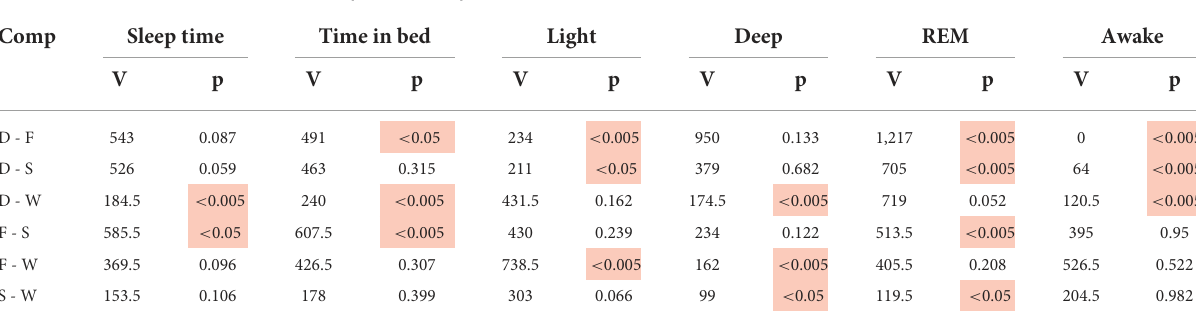
TABLE 4 Wilcoxon rank sum test results of pairwise comparison.